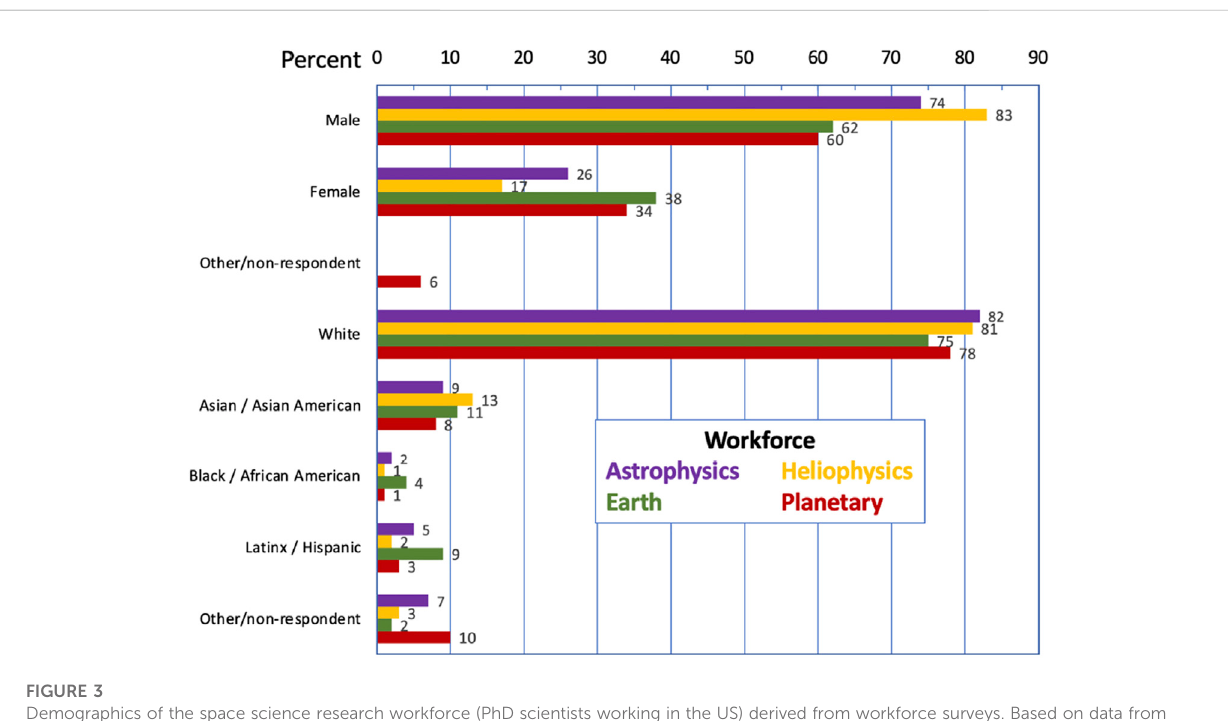
FIGURE 3 Demographics of the space science research workforce (PhD scientists working in the US) derived from workforce surveys. Based on data from BernardandCooperdock(2018),NationalScienceFoundationNationalCenterforScienceandEngineeringStatistics,PoldandIvie(2018),PorterandIvie (2019), Porter et al. (2020), and White et al. (2011a).